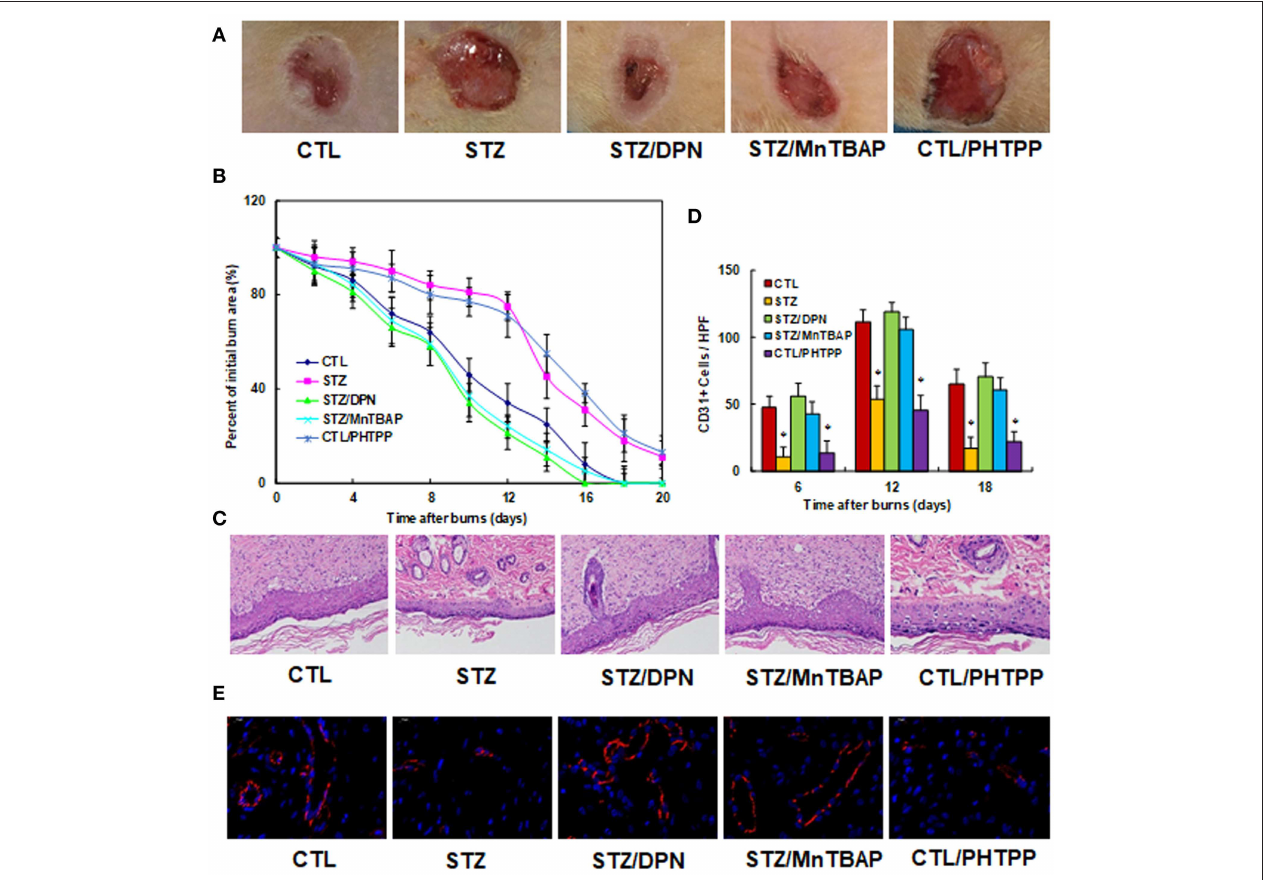
FIGURE 5 | ER β activation accelerates wound healing in diabetic rats. The experimental rats were divided into 5 groups: control (CTL), diabetic (STZ) treatment, STZ rats treated by 450 µ g/kg/day of DPN (STZ/DPN), STZ rats treated by 10 mg/kg/day of MnTBAP (STZ/MnTBAP), or CTL rats treated by 450 µ g/kg/day of PHTPP (CTL/PHTPP), for further analysis. (A) Photographs of representative wounds on day 12 after burns. (B) Graphical depiction of wound area in different days after burns. (C) H&E stains of wound tissue on day 12 after burns with occurrence of granulation tissue in the wounds. (D) Numbers of CD31 positive vessels per HPF area on day 12 after burns. (E) The representative pictures for the evaluation of vascularity (assessed by CD31 immunohistochemistry) on day 12 after burns. N = 7. * P < 0.05, vs. CTL group. Data are expressed as mean ±